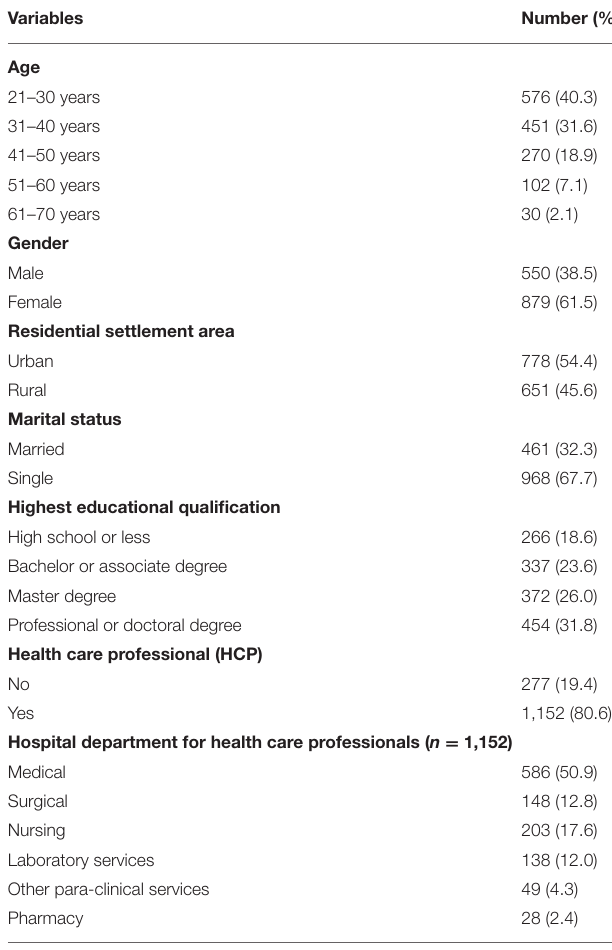
TABLE 1 | The participants demographical